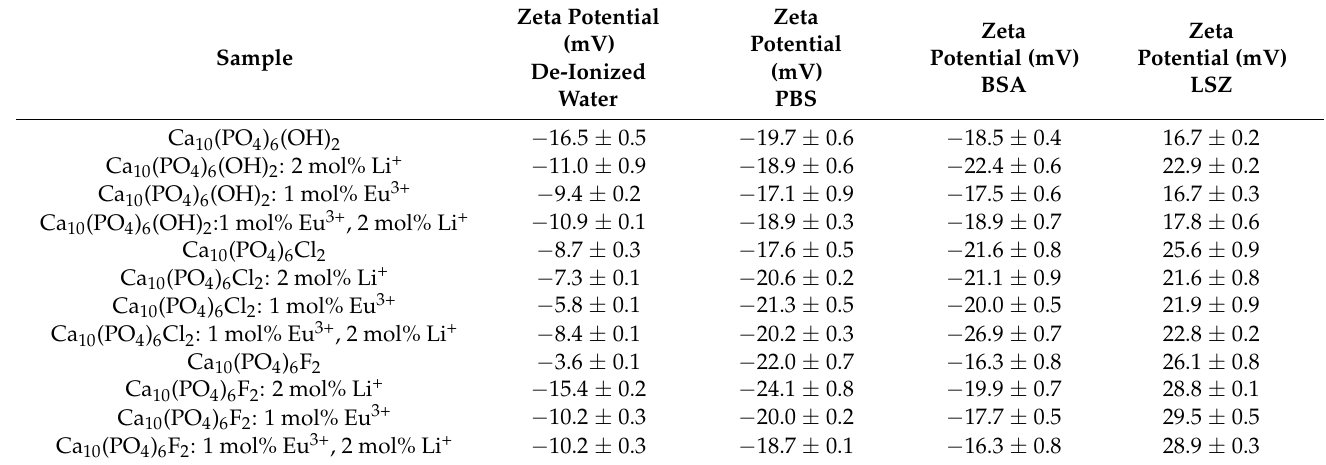
Table 4. Zeta potentials of nanoapatites series in de-ionized water, PBS, BSA and LSZ suspensions.